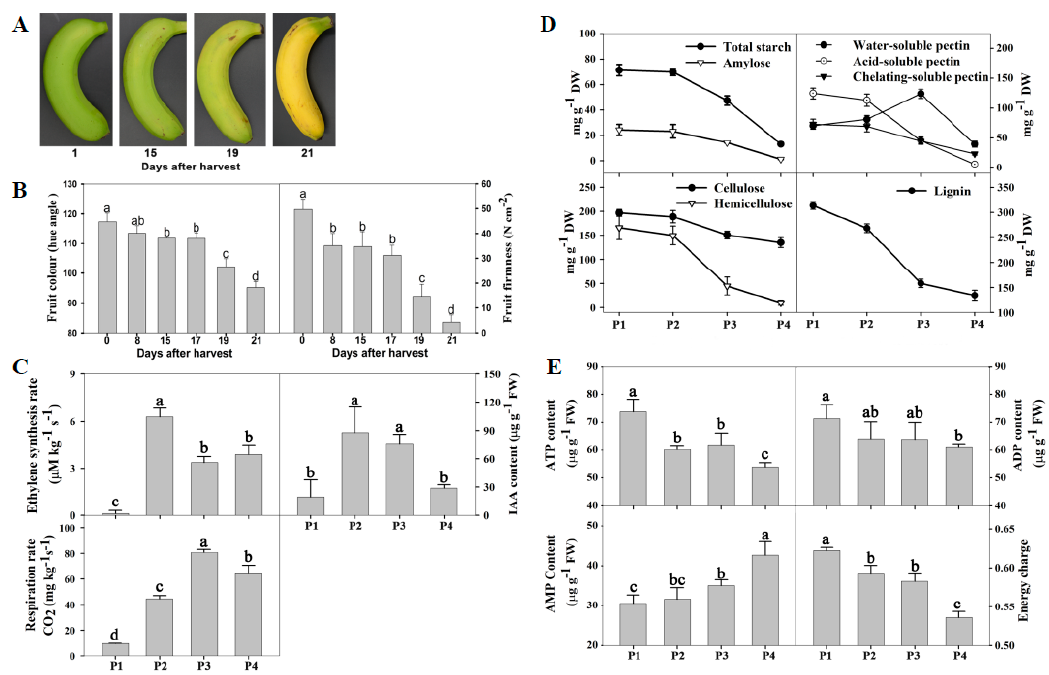
Figure 1. The changes in the physiological parameters of banana fruit during ripening. Banana fruit were stored at 25 °C and 85% to 90% relative humidity. ( A ) Visual appearance of banana fruit stored for 1, 15, 19, and 21 days, defined as P1, P2, P3, and P4, respectively (the same below); ( B ) fruit color, firmness, ethylene production rate, 3-indoleacetic acid (IAA) content, and respiration rate; ( C ) the contents of starch and cell wall compounds (cellulose, hemicellulose, water-soluble pectin, ionic-soluble pectin, covalent-soluble pectin, and lignin) in the peel; ( D , E ) the contents of adenosine triphosphate (ATP), adenosine diphosphate (ADP), and adenosine monophosphate (AMP), and energy charge in the peel. FW, fresh weight. DW, dry weight. P1, the sample at 1 day. P2, the sample at 15 days. P3, the sample at 19 days. P4, the sample at 21 days.